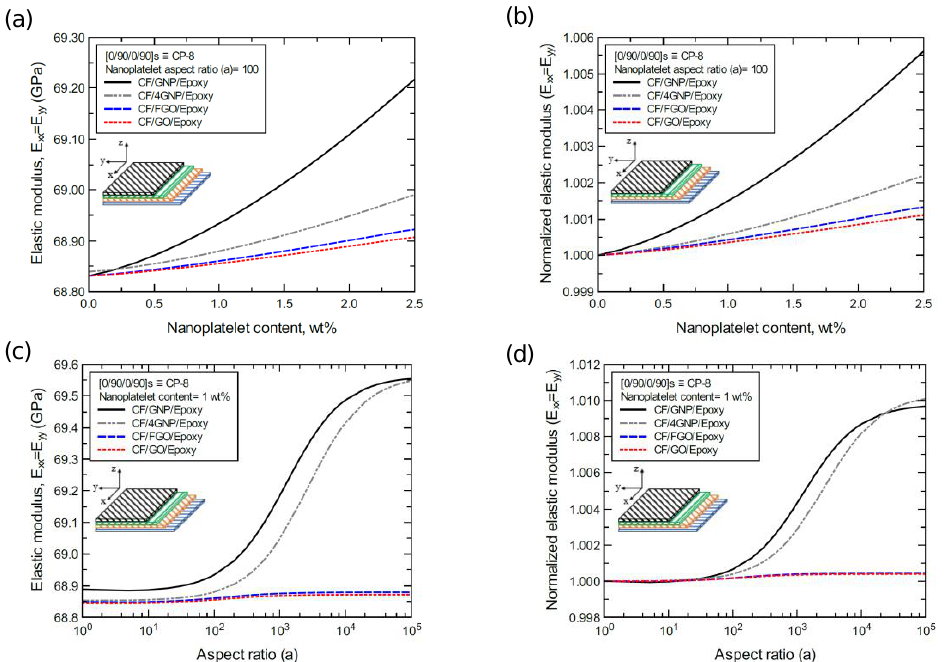
Figure 18. Comparison of the predicted in-plane elastic modulus (E xx = E yy ) for a [0/90/0/90]s (CP-8)-laminated composite plate based on the nanoplatelet type, content, and aspect ratio; ( a ) predicted E xx for various nanoplatelet contents at 100 aspect ratio, and the normalized response is shown in ( b ); ( c ) predicted E xx for various aspect ratio values at 1.0 wt% nanoplatelet content, and the normalized response is shown in ( d ). The volume fraction of CF is 56%.